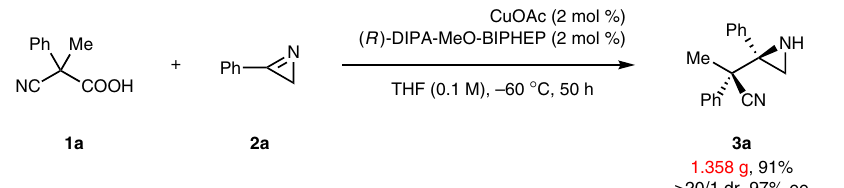
Fig. 2 Gram-scale reaction. Conditions: 1a (9 mmol, 1.577 g), 2a (6 mmol, 0.703 g), CuOAc (2 mol %), ( R )-DIPA-MeO-BIPHEP (2 mol %), and